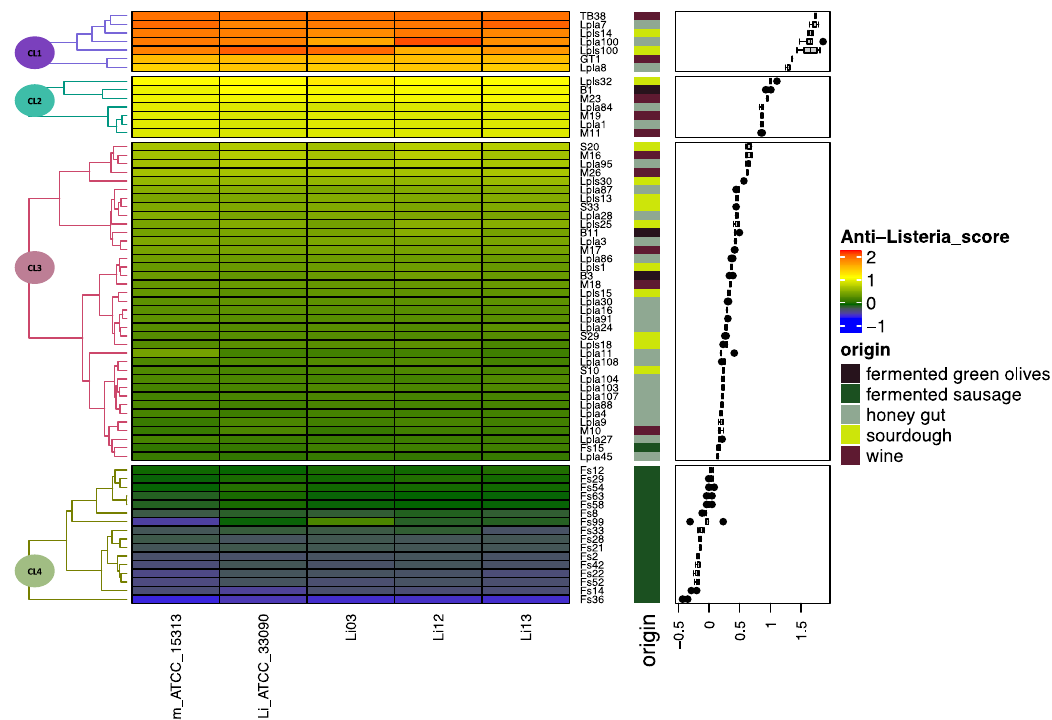
Figure 1. Cluster analysis shown as a heat-map with boxplot annotation concerning the anti- Listeria activity (Anti- Listeria _score) produced by sixty-seven Lactiplantibacillus plantarum strains isolated from di ff erent sources (origin). The anti- Listeria activity was assayed against Listeria monocytogenes (Lm_ATCC_15313) and four strains of Listeria innocua (Li_ATCC_33090, Li03, Li12, Li13).